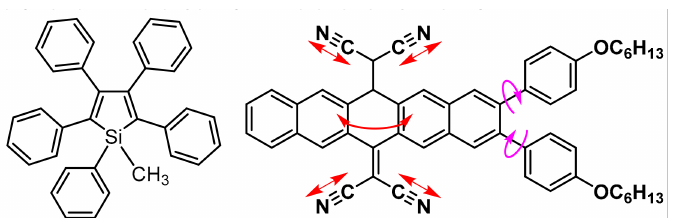
Figure 9. The molecular structure of 1-methyl-1,2,3,4,5-pentaphenylsilole and pentacenequinone